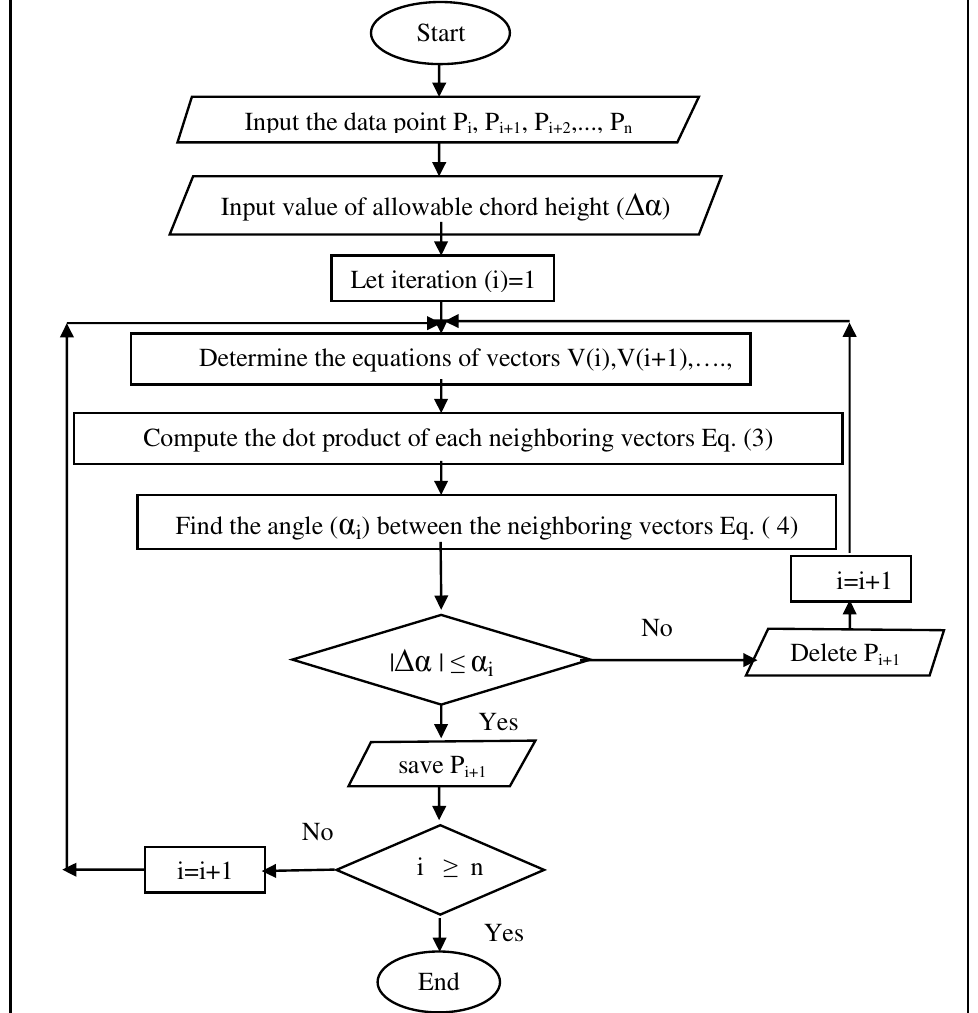
Fig. 3. Flowchart for proposed Chord Angle Pre-Processing